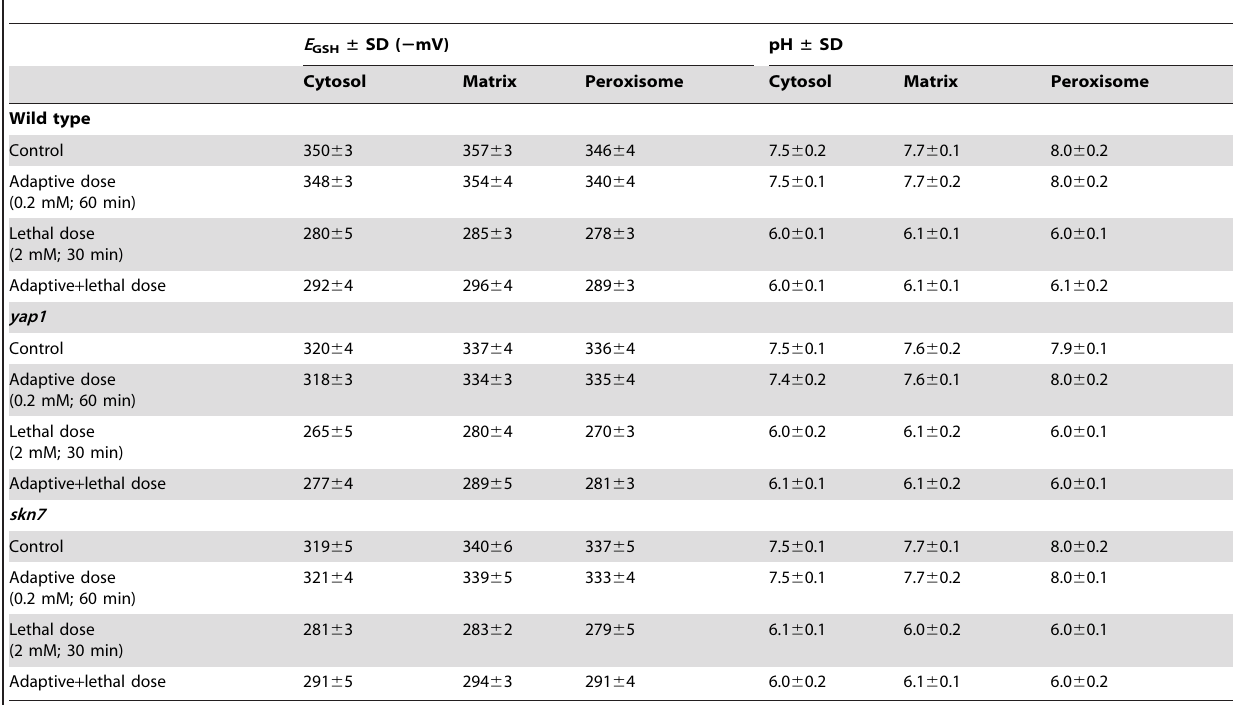
Table 3. E GSH and pH of wild type, yap1 and skn7 cells grown in SC URA to exponential phase and during the adaptive response to hydrogen peroxide